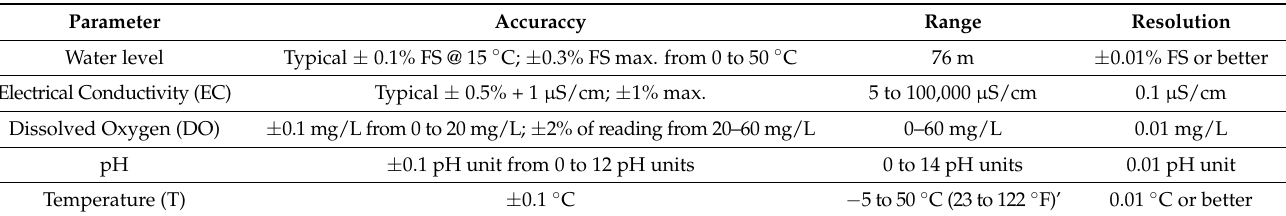
Table 1. In-Situ AT400 manufacturer specifications